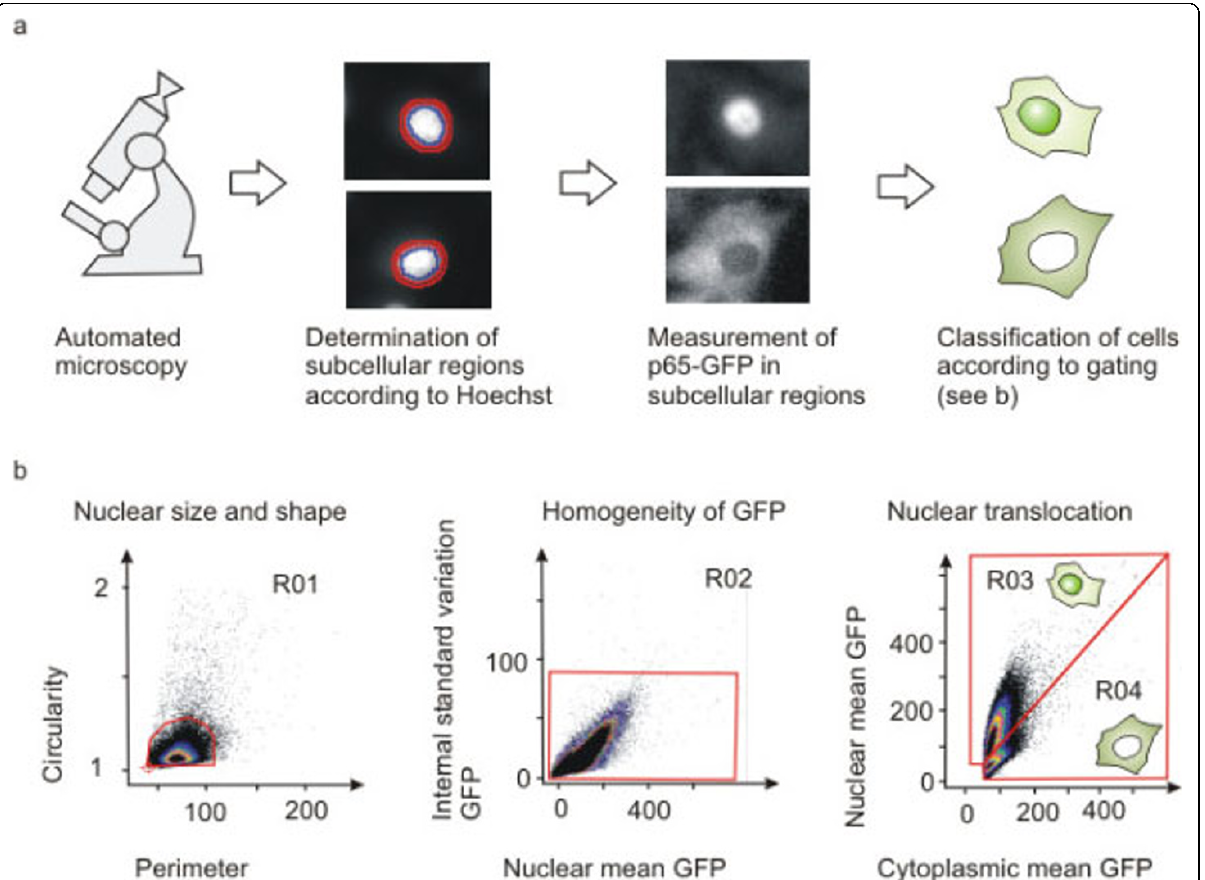
Figure 2 The NF- (cid:1) B readout: p65-GFP reporter cells A549 SIB01 and automated microscopy. a) Workflow of automated microscopy and picture analysis. Cells are fixed and stained with Hoechst 33342. Pictures are then acquired with the Scan^R system and nuclear (blue) and cytoplasmic (red) areas are defined in the Scan^R software. One activated (top) and one non-activated cell (bottom) is depicted. b) Translocation assay using Scan^R Analysis. Cells were seeded on 96-well plates, activated with TNF a (10 ng/ml), fixed, stained with Hoechst 33342 and then analyzed with automated microscopy. Scatter plots as depicted in the analysis software are shown. Cells are gated for circularity and size (Region R01), intensity of GFP and standard deviation of GFP intensity (Region R02). Cells in regions R01 and R02 are classified as active or inactive according to nuclear and cytoplasmic GFP intensity (Region R03 or R04). Cells with nuclear p65-GFP are also in region R03, whereas cells with mainly cytoplasmic p65-GFP are also in gate